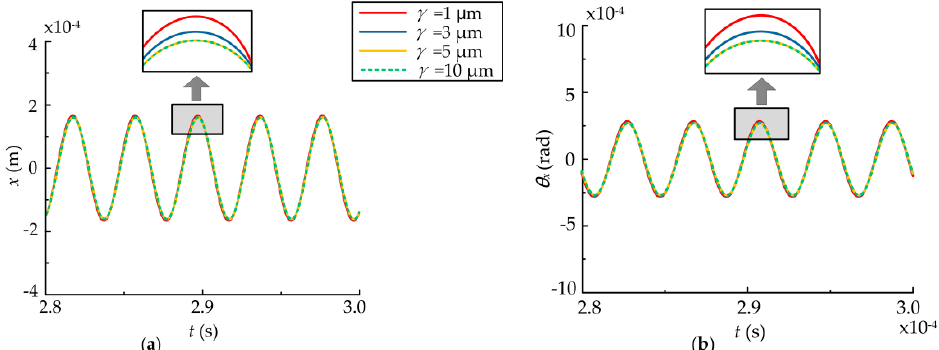
Figure 13. Time history of the dynamic responses for different radial clearances. ( a ) Time history of x ; ( b ) Time history of θ x .